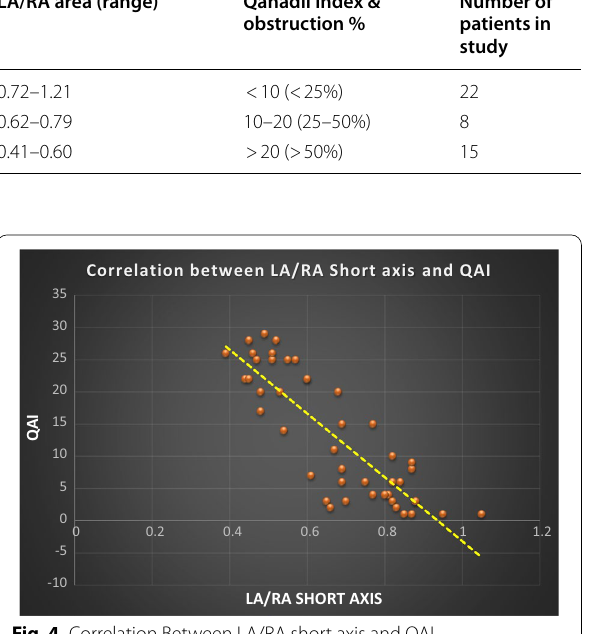
Fig. 4 Correlation Between LA/RA short axis and QAI